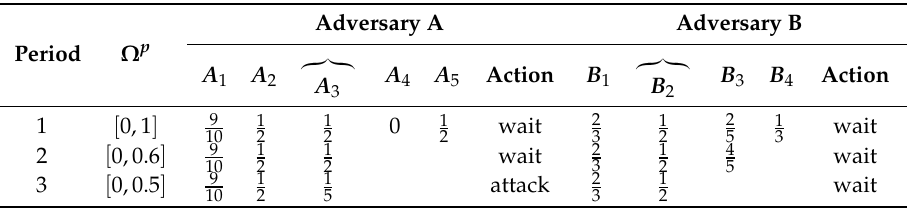
Table 2. Dynamics when true state of world is ω ∈ ( 0.4,0.5 ]